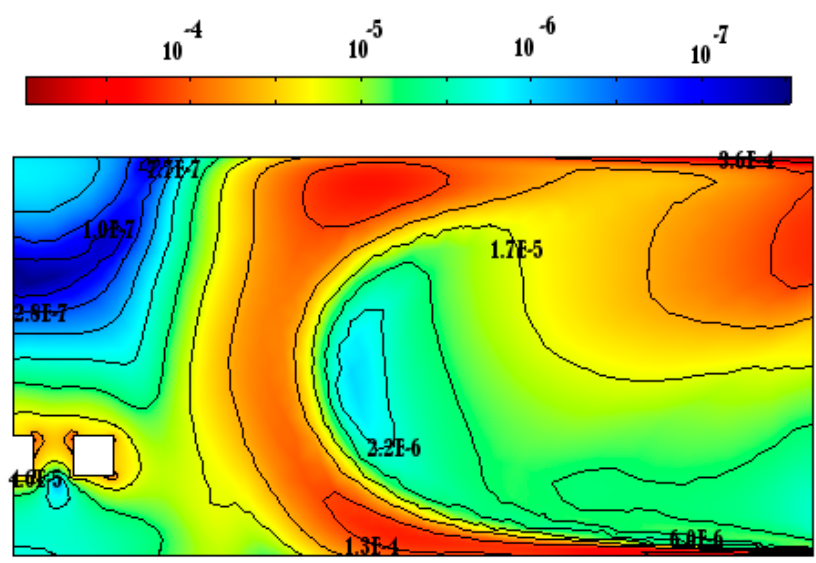
Figure 7. Dimensionless rate of total entropy generation for N = 3, N r = 1, and A R = 1/2.